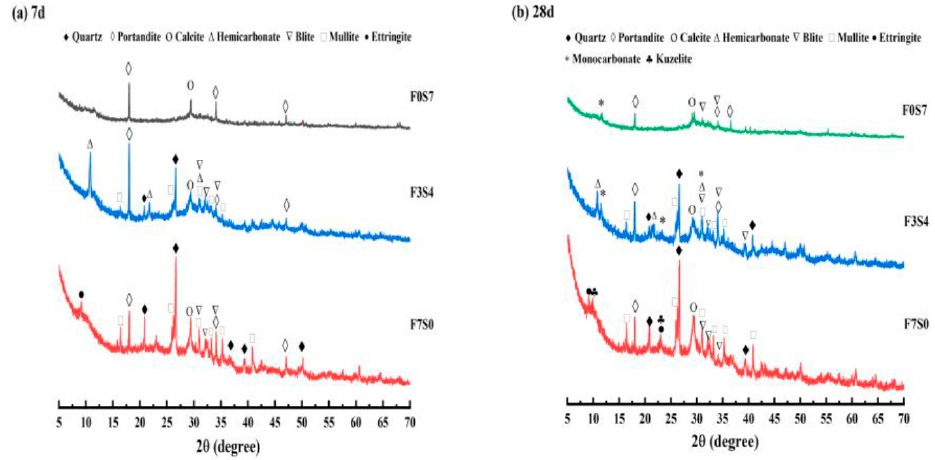
Figure 5. XRD patterns of the LCFLS: ( a ) 7 d; ( b ) 28 d.